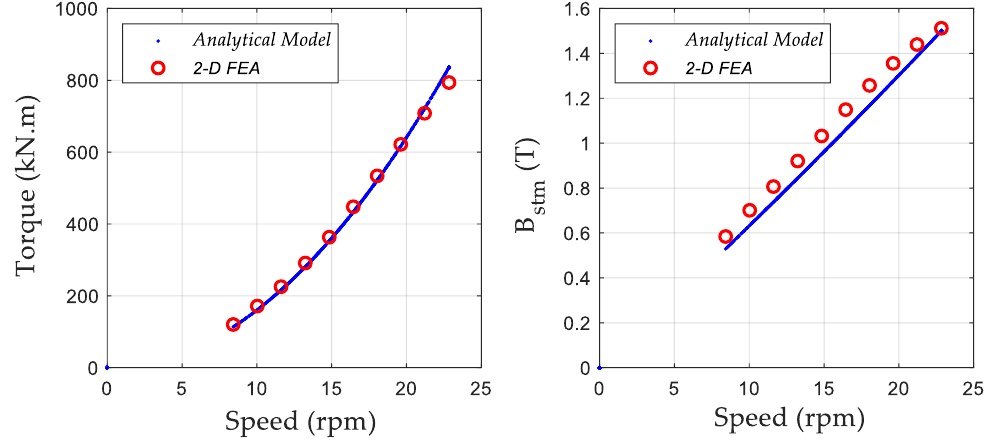
Figure 12. Torque and flux density in the stator teeth with the speed.